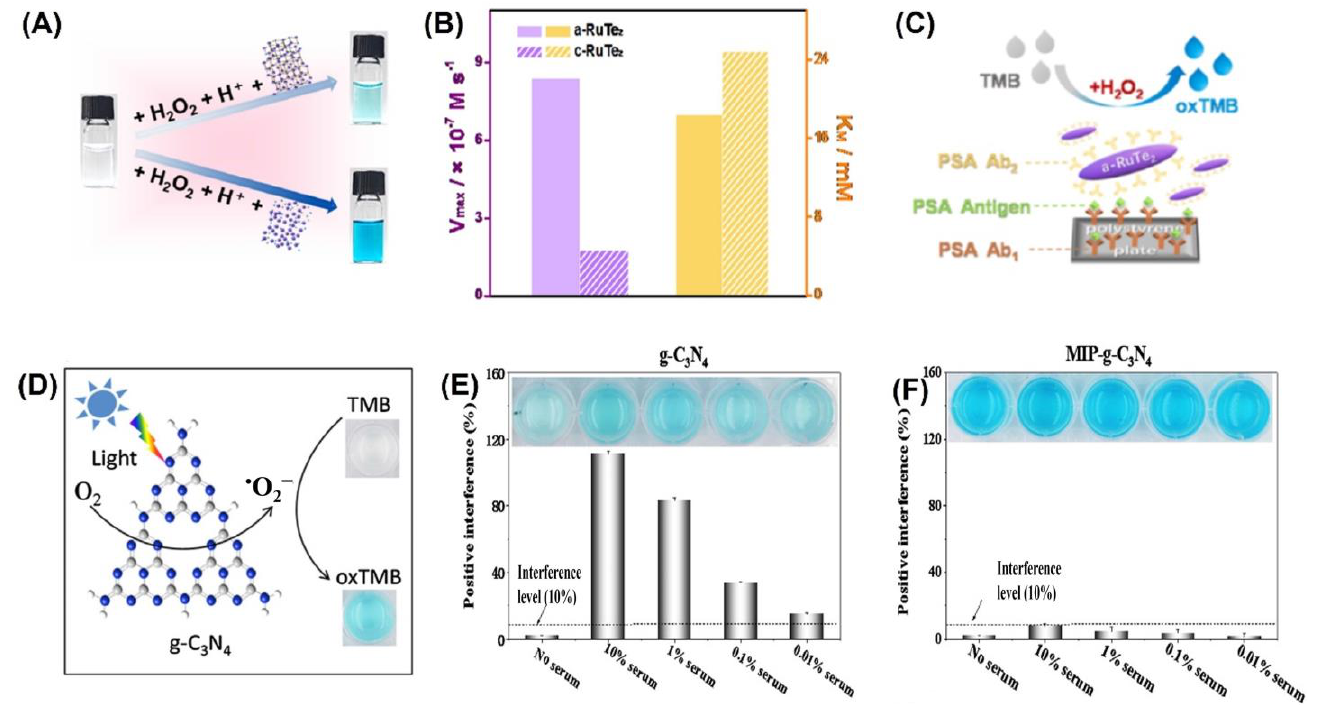
Figure 3. ( A ) RuTe 2 nanorods demonstrate peroxidase-like activity by catalyzing the oxidation of TMB similar to POD. ( B ) Comparison of the enzymatic parameters V max and K M of amorphous and crystalline RuTe 2 using H 2 O 2 as a substrate. ( C ) Representation of the colorimetric a-RuTe 2 -ELISA for detecting PSA. ( D ) Illustration of g-C 3 N 4- catalyzed oxidation of TMB. Experimental conditions: g-C 3 N 4 concentration of 20 mg/mL, solution pH of 4.0, TMB concentration of 0.5 mmol/L, and blue LED color. Interfering matrices from serum samples are demonstrated in ( E ) g-C 3 N 4 and ( F ) MIP-g- C 3 N 4 . Reprinted with permission from refs.